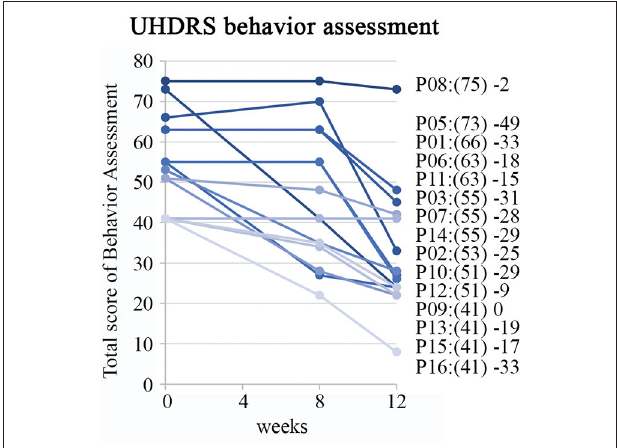
FIGURE 3 | Improvement on behavior assessment measures of UHDRS. Individual patient profiles are shown with captions including baseline sum of frequency x severity scores in brackets and difference between baseline and assessed scores at the week